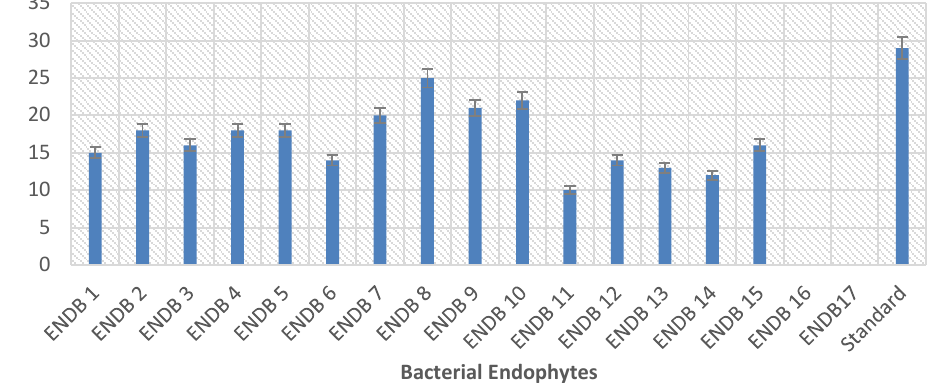
Figure 2 . Antimicrobial potentiality spectra of bacterial endophytes against S. pyogenes